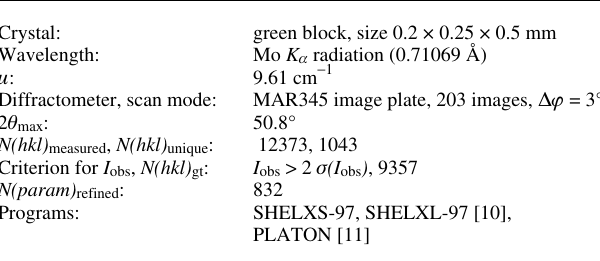
Table 1. Data collection and